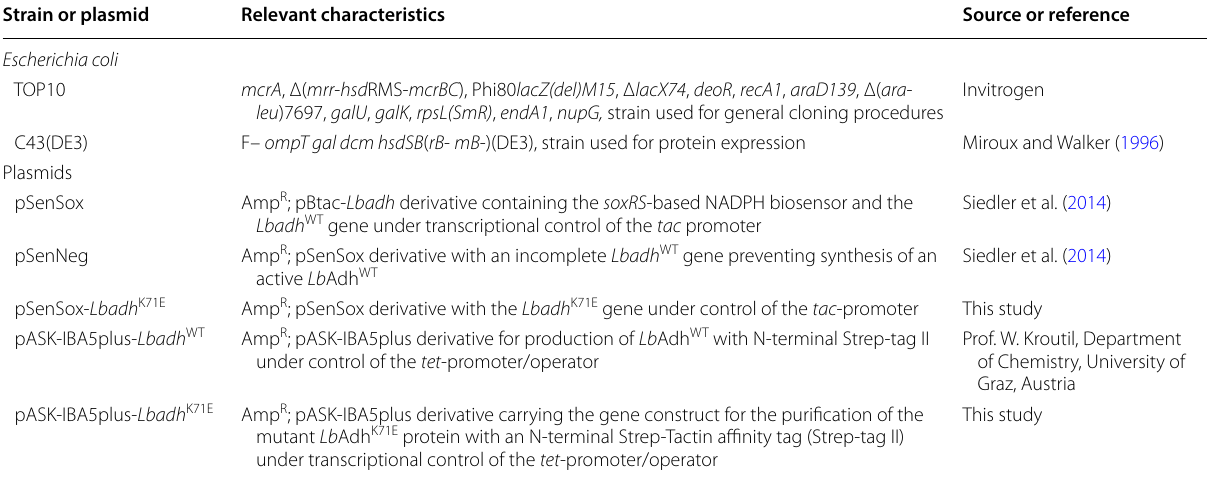
Table 1 Bacterial strains and plasmids used in this study Strain or plasmid Relevant characteristics